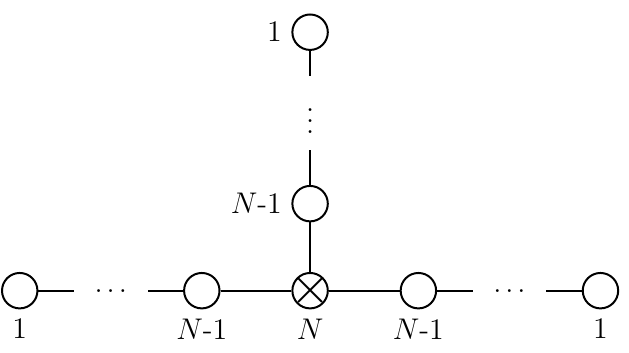
Figure 23 . The magnetic quiver for the T N theory. The unbalanced nodes will be marked with a cross. For N = 3 the central node is also balanced and the (cid:13)avor symmetry is G F;T R 3 . However, we can only do this as long as the web at each point in R 3 R